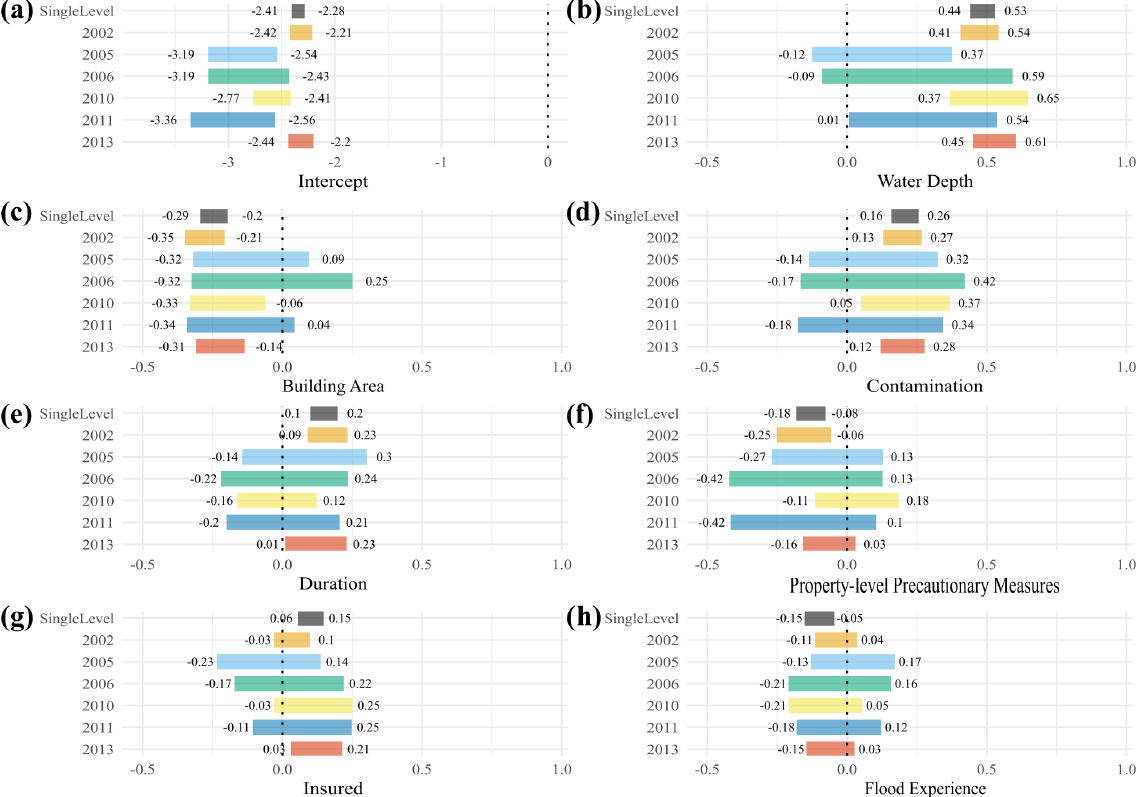
Figure 5. The 95% HDI of regression estimates of the flood-event model (each event coded by colour) and the single-level model (black bars). The intercept is the sum of the population-level effect (common across levels) and group-level effects (for each